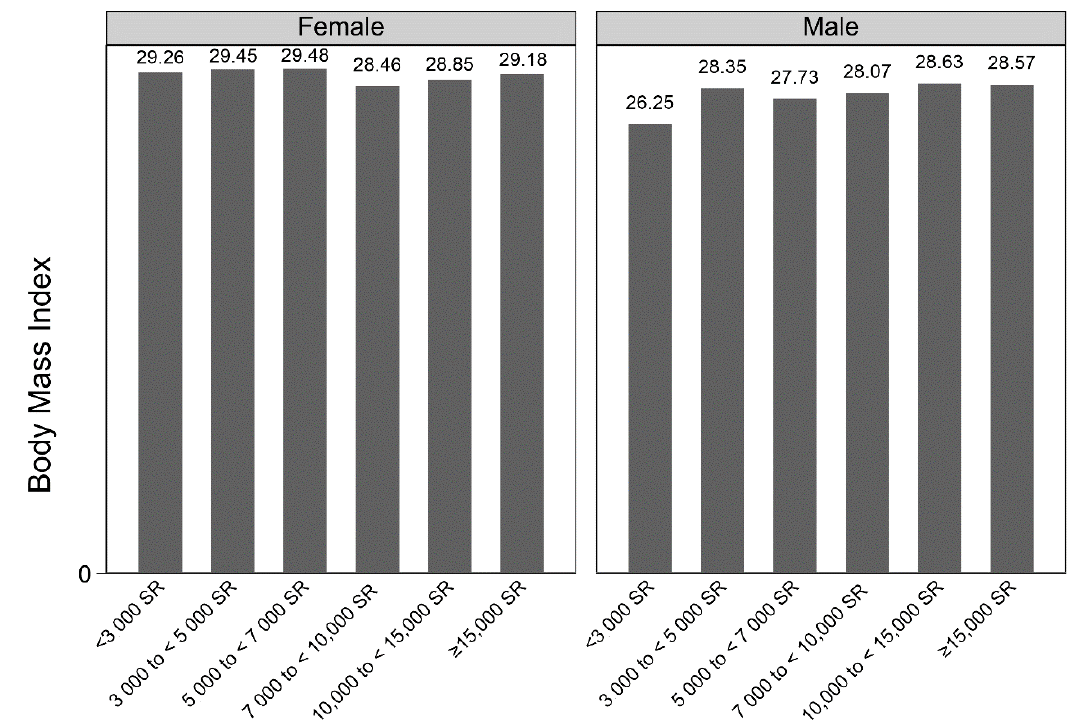
Figure 2. BMI distribution across income by gender. Results from the 2013 Saudi Health Interview Survey (SHIS).